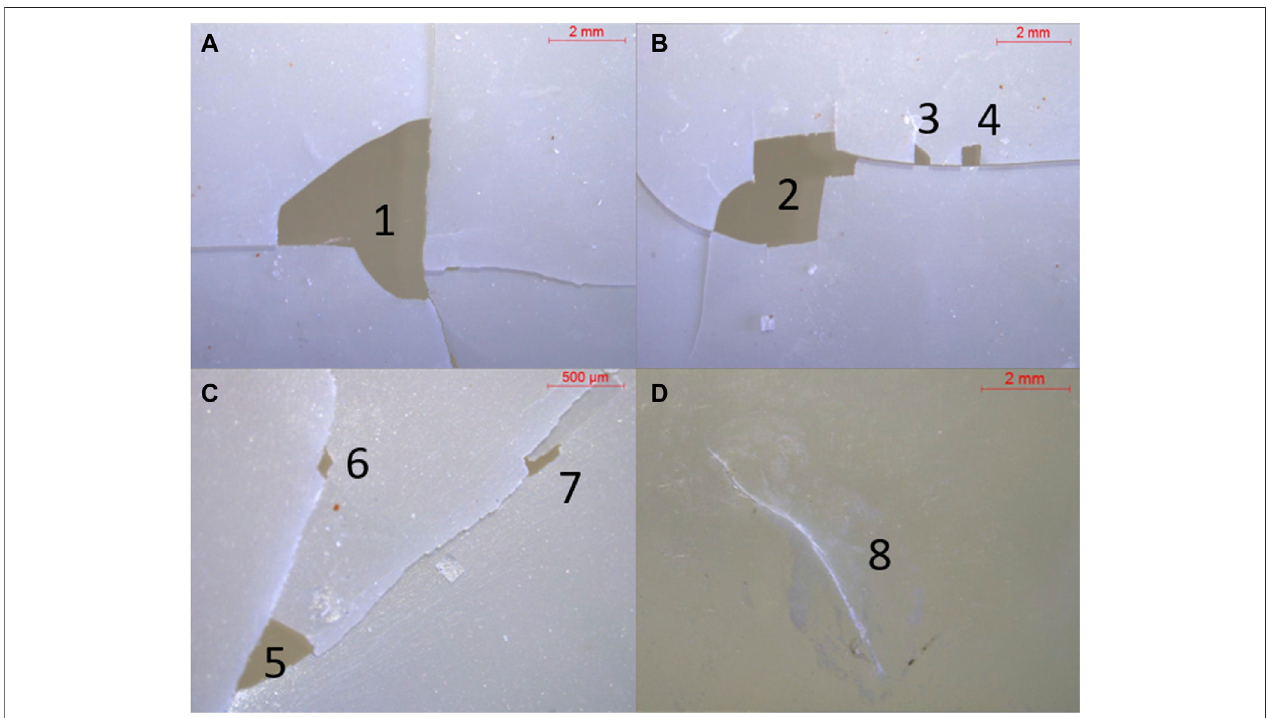
FIGURE 2 | Stereo microscope images of surface loss and changes in PHA (A-C) and PLA (D) fi lms after exposure (hole sizes in mm 2 : 1 (cid:2) 11.011, 2 (cid:2) 6.703, 3 (cid:2) 0.130, 4 (cid:2) 0.230, 5 (cid:2) 0.115, 6 (cid:2) 0.008, 7 (cid:2) 0.018).